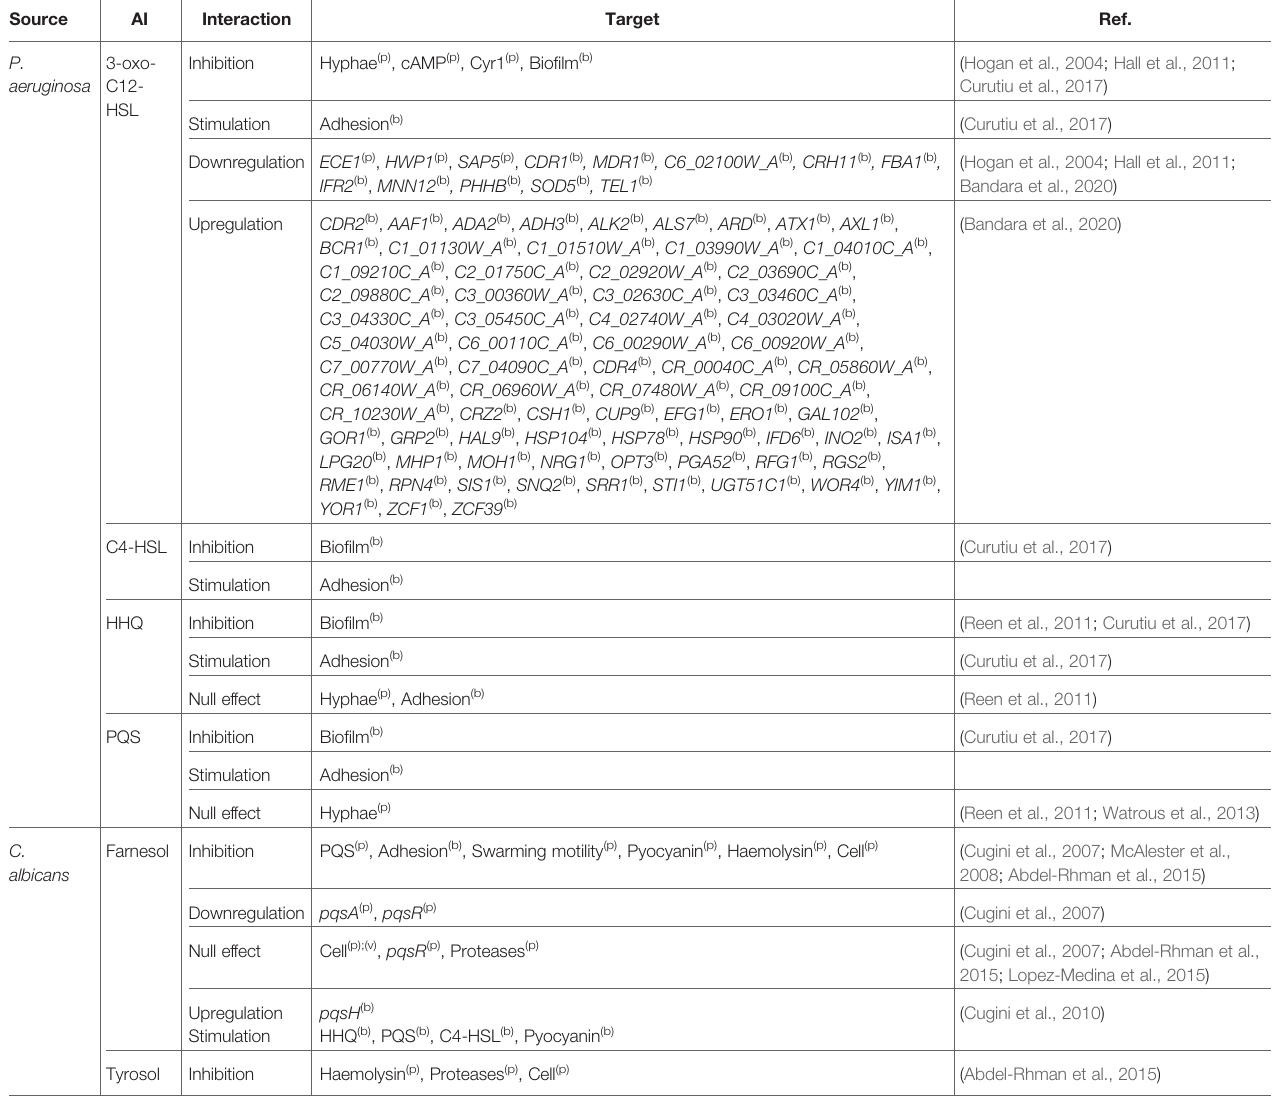
TABLE 1 | Effect of AI on P. aeruginosa - C. albicans interactions.